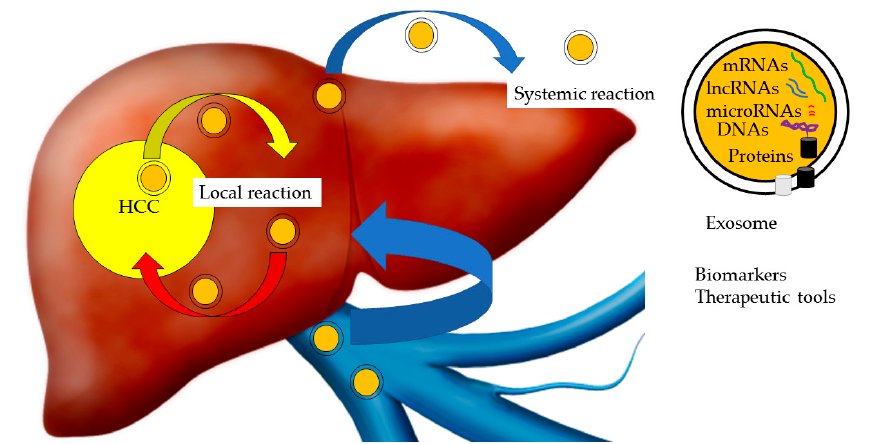
Figure 1. Exosomes and hepatocellular carcinoma (HCC). Exosomes transfer proteins, DNAs and various forms of RNA, such as microRNA (miRNA), long noncoding RNA (lncRNA) and messenger RNA (mRNA), between HCC and non-HCC cells. Exosomes induce local and systemic reactions, contributing to the development of HCC. Exosomes are useful biomarkers and therapeutic tools for